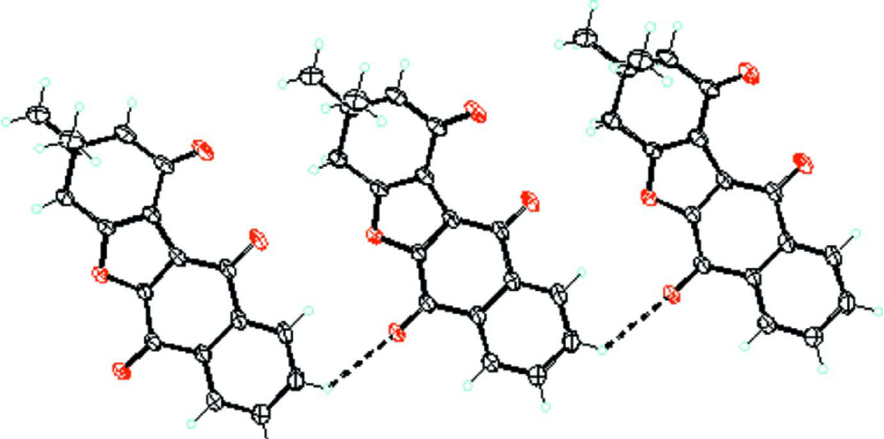
Figure 2 Hydrogen-bonding of the title